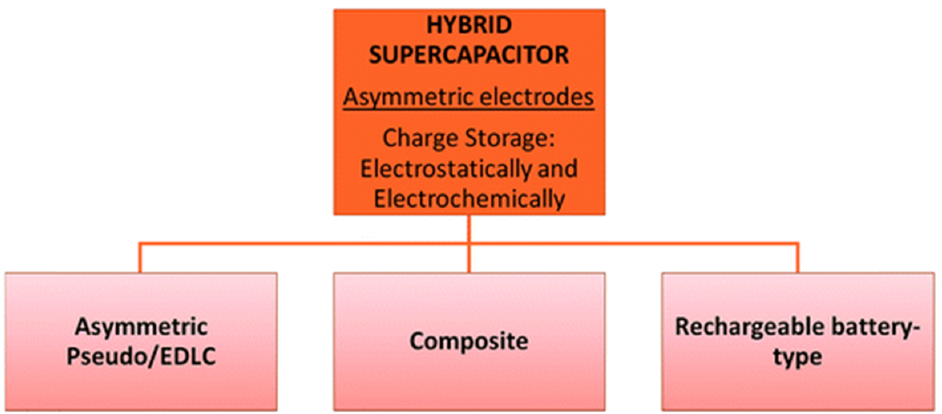
Figure 6. Hybrid supercapacitors are classified into three types based on their working and design. Reprinted with permission from ref. [98]. Copyright 2019 Royal Society of Chemistry.